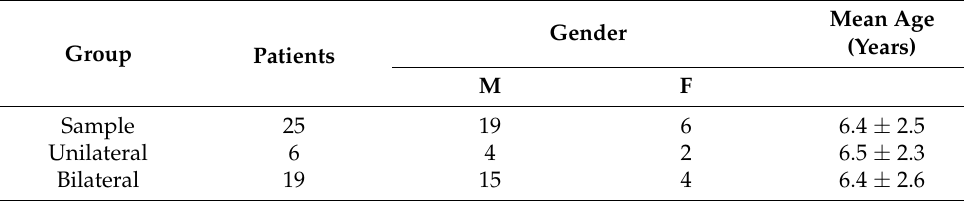
Table 1. Group demographics.